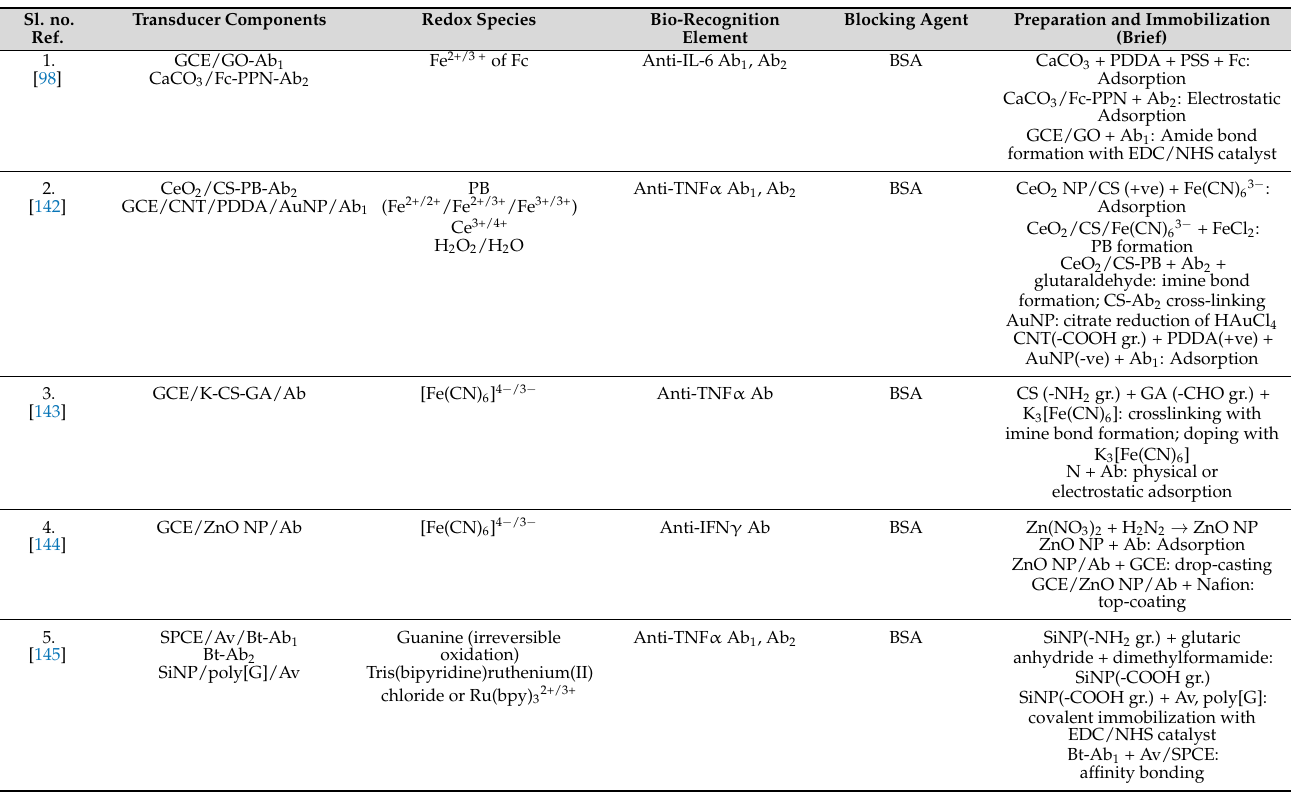
Table 9. Redox-labeled immunosensors: Design and sensor preparation. Sl. no. Ref.